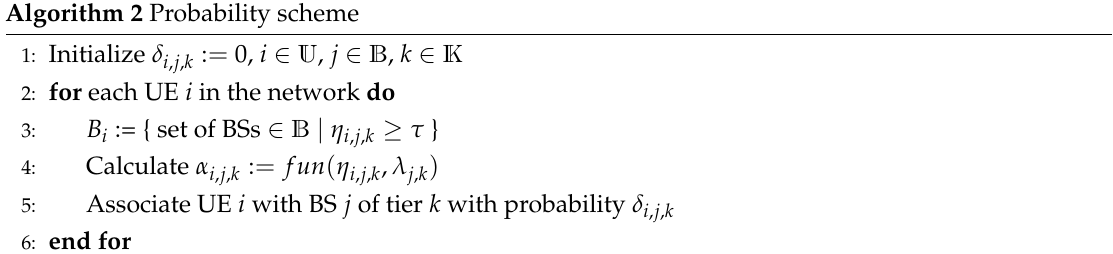
Algorithm 2 Probability